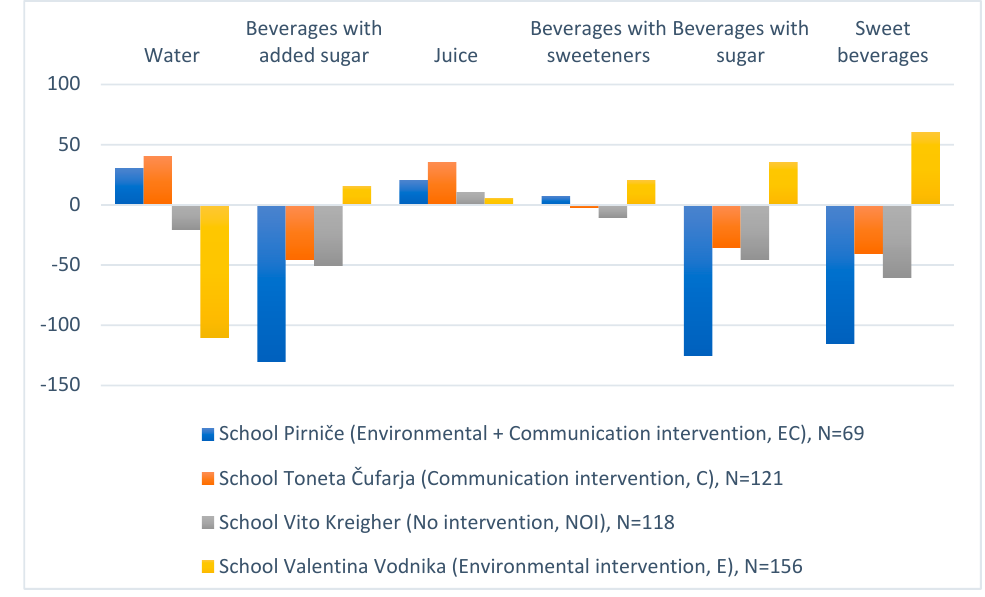
Figure 1. Quantity of beverages (mL/day) consumed on average by children of the communication intervention school (C); the environmental and communication intervention school (EC); the control school (NOI); and the environmental intervention school (E) .